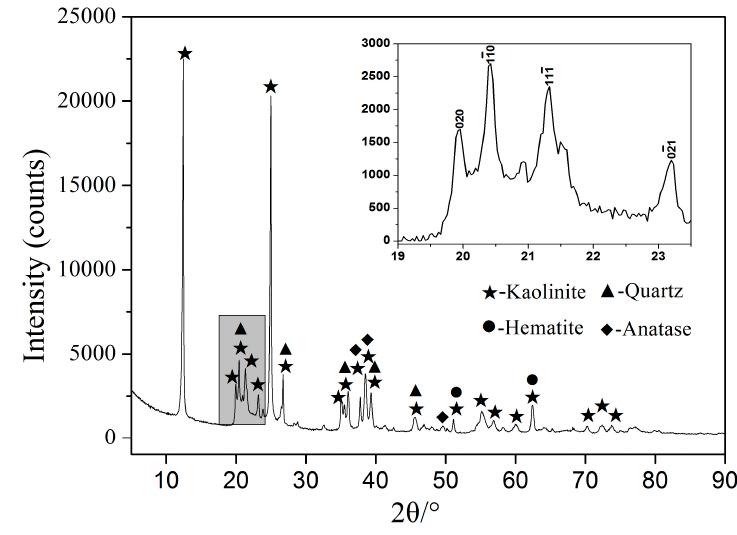
Figure 2. X-ray diffraction ( XRD) pattern of raw coal gangue. Table 1. Chemical composition of coal gangue (mass %). VM: Volatile matter; LOI: Loss on ignition.